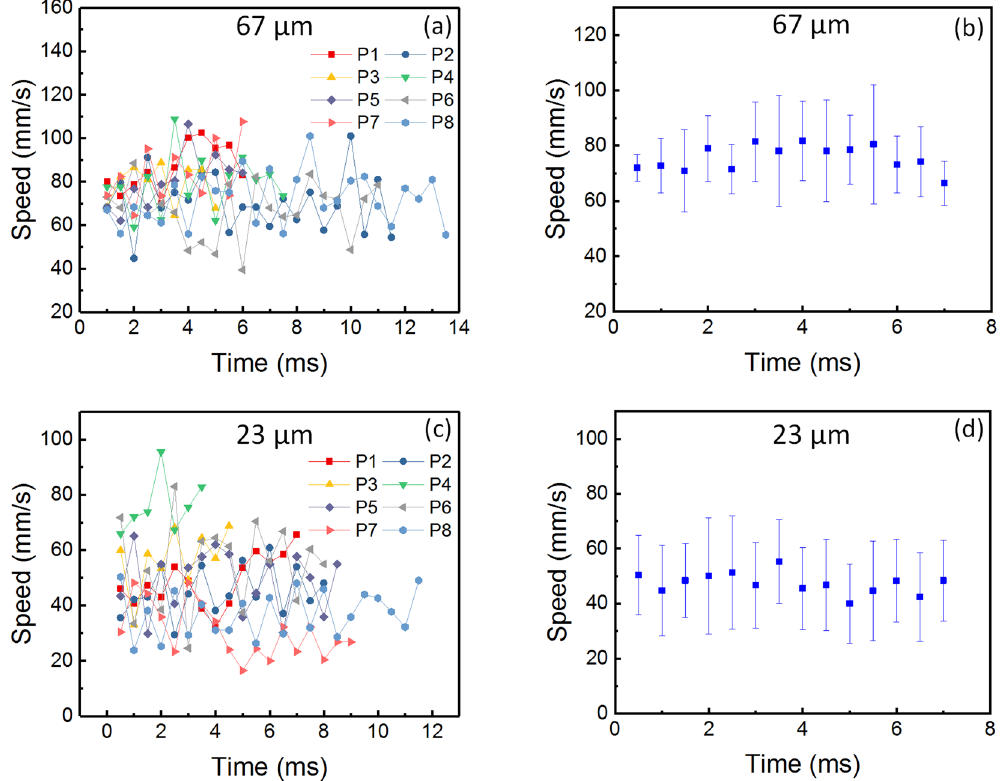
Figure 5. Slope surface flow speed. ( a , b ) Slope surface flow speed versus time for each tracked particle ( a ) and average surface flow speed ( b ) for 316 L stainless steel powder with average diameter of 67 µ m. ( c , d ) Slope surface flow speed versus time for each tracked particle ( c ) and average surface flow speed ( d ) for 316 L stainless steel powder with an average diameter of 23 µ m. Eight particles on the surface of the powder slope were tracked for each powder size. The 316 L stainless steel powder with an average diameter of 67 µ m presented an average slope surface flow speed of 77 mm/s with a standard deviation of 7 mm/s. The 316 L stainless steel powder with an average diameter of 23 µ m presented an average slope surface flow speed of 50 mm/s with a standard deviation of 14